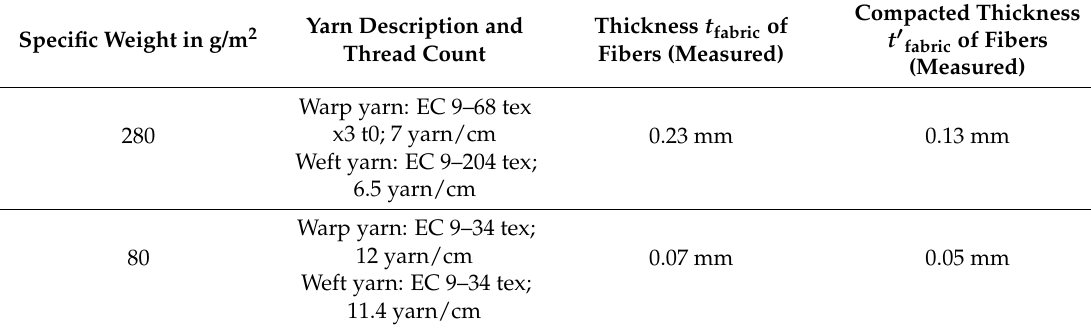
Table 1. Parameters of twill woven fibers.